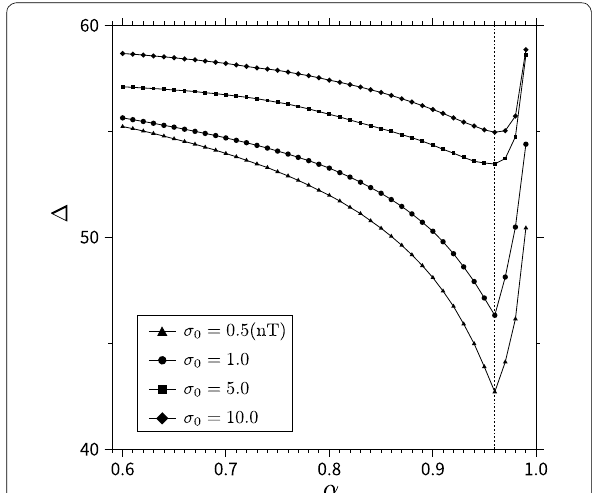
Fig. 7 Plot of (cid:31) for α . Plot of (cid:31) for α in the range of 0.60 to 0.99 with an interval of 0.01, using the weighting function w S 1 . The solid triangles, circles, squares, and diamonds indicate the case of σ 0 1.0, 5.0, and 10.0 nT, respectively